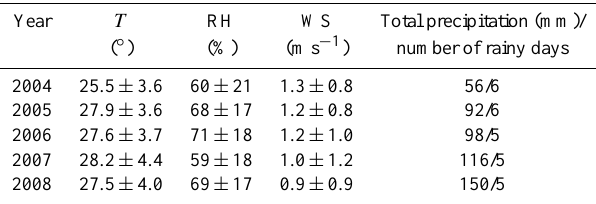
Table 2. Statistics of meteorological parameters in August from 2004 to 2008.